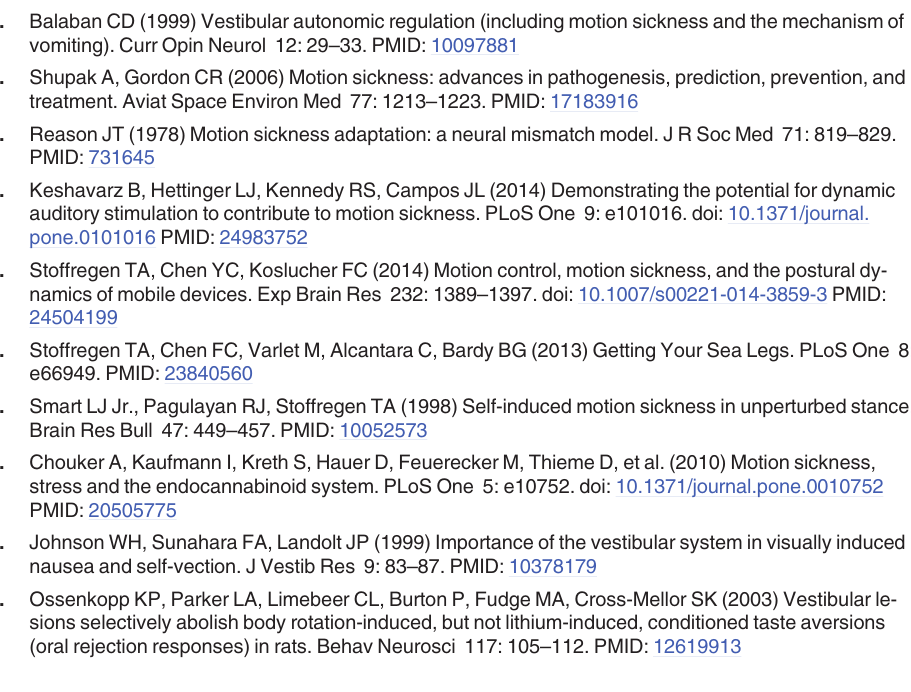
S1 Table. The primer sequences used for real-time PCR. S2 Table. Fifty-five of the most up-regulated genes in the CVN of MSS-Rot animals com- pared with the inMSS-Rot group. S3 Table. Seventeen of the most down-regulated genes in the CVN of MSS-Rot animals compared to the inMSS-Rot group. S4 Table. The statistically significant up-regulated and down-regulated pathways (p < 0.05) and the number of associated genes in each pathway. S5 Table. Real-time qPCR verification of microarray data for differentially expressed genes in the